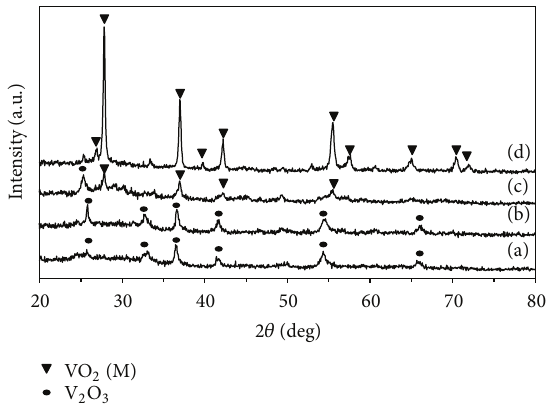
Figure 8: XRD patterns of vanadium oxide powders prepared by calcination of the 300 W microwave heated samples at 400 ∘ C for 1h with different molar ratios of NH 4 VO 3 and oxalic acid: (a) 2: 2.7, (b)